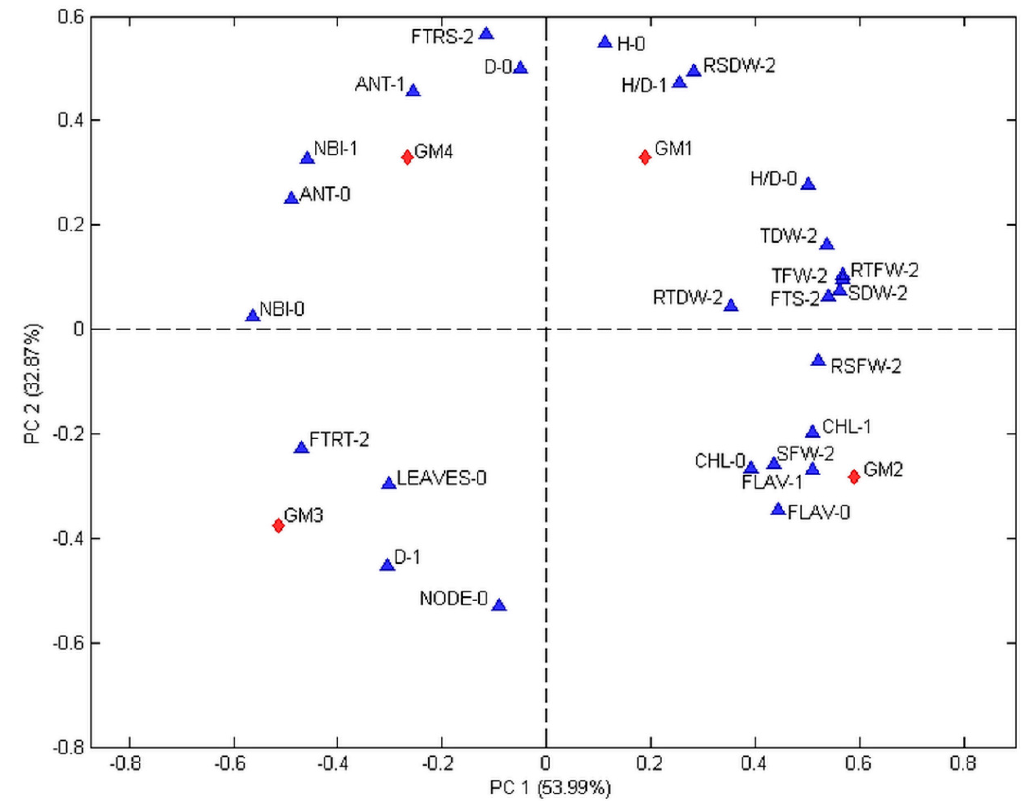
Figure 1. Ordination biplots of principal component analysis outputs of the data from bench-grafts grown on growing media (GM), containing composted solid digestate (CSD) at different rates. GM1 = commercial peat (CP) 100%; GM2 = CP 90% + CSD 10%; GM3 = CP 80% + CSD 20%; GM4 = CP 60% + CSD 40%. Labels in the triangles indicate the investigated parameters: Leaf chlorophyll content (CHL); leaf flavonoid content (FLAV); nitrogen balance index (NBI); leaf anthocyanins (ANT); plant height (H); height diameter ratio (H/D); shoot fresh weight (SFW); rootstock fresh weight (RSFW); root fresh weight (RTFW); total fresh weight (TFW); shoot dry weight (SDW); rootstock dry weight (RSDW); root dry weight (RTDW); total dry weight (TDW); fraction to shoot (FTS); fraction to rootstock (FTRS); fraction to root (FTRT). 0 = parameter recorded at 170 day of year (DOY); 1 = parameter recorded at 275 DOY; 2 = parameter recorded at 362 DOY.